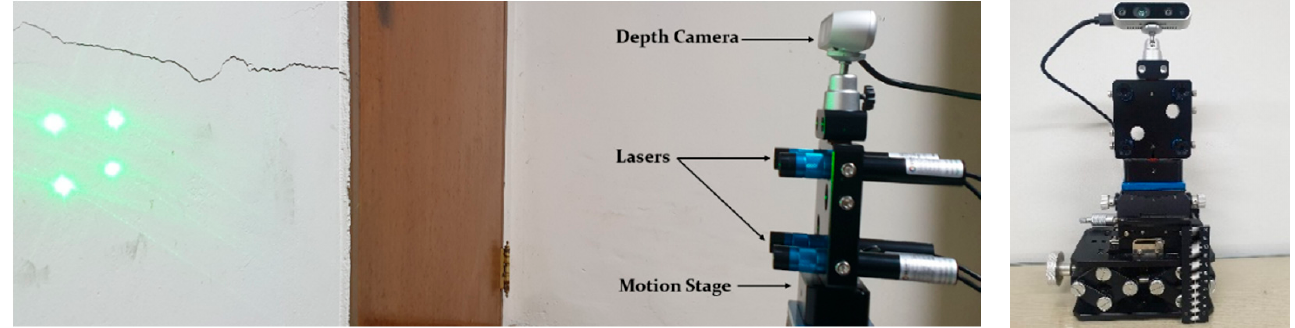
Figure 4. Experimental setup using a depth camera and lasers.